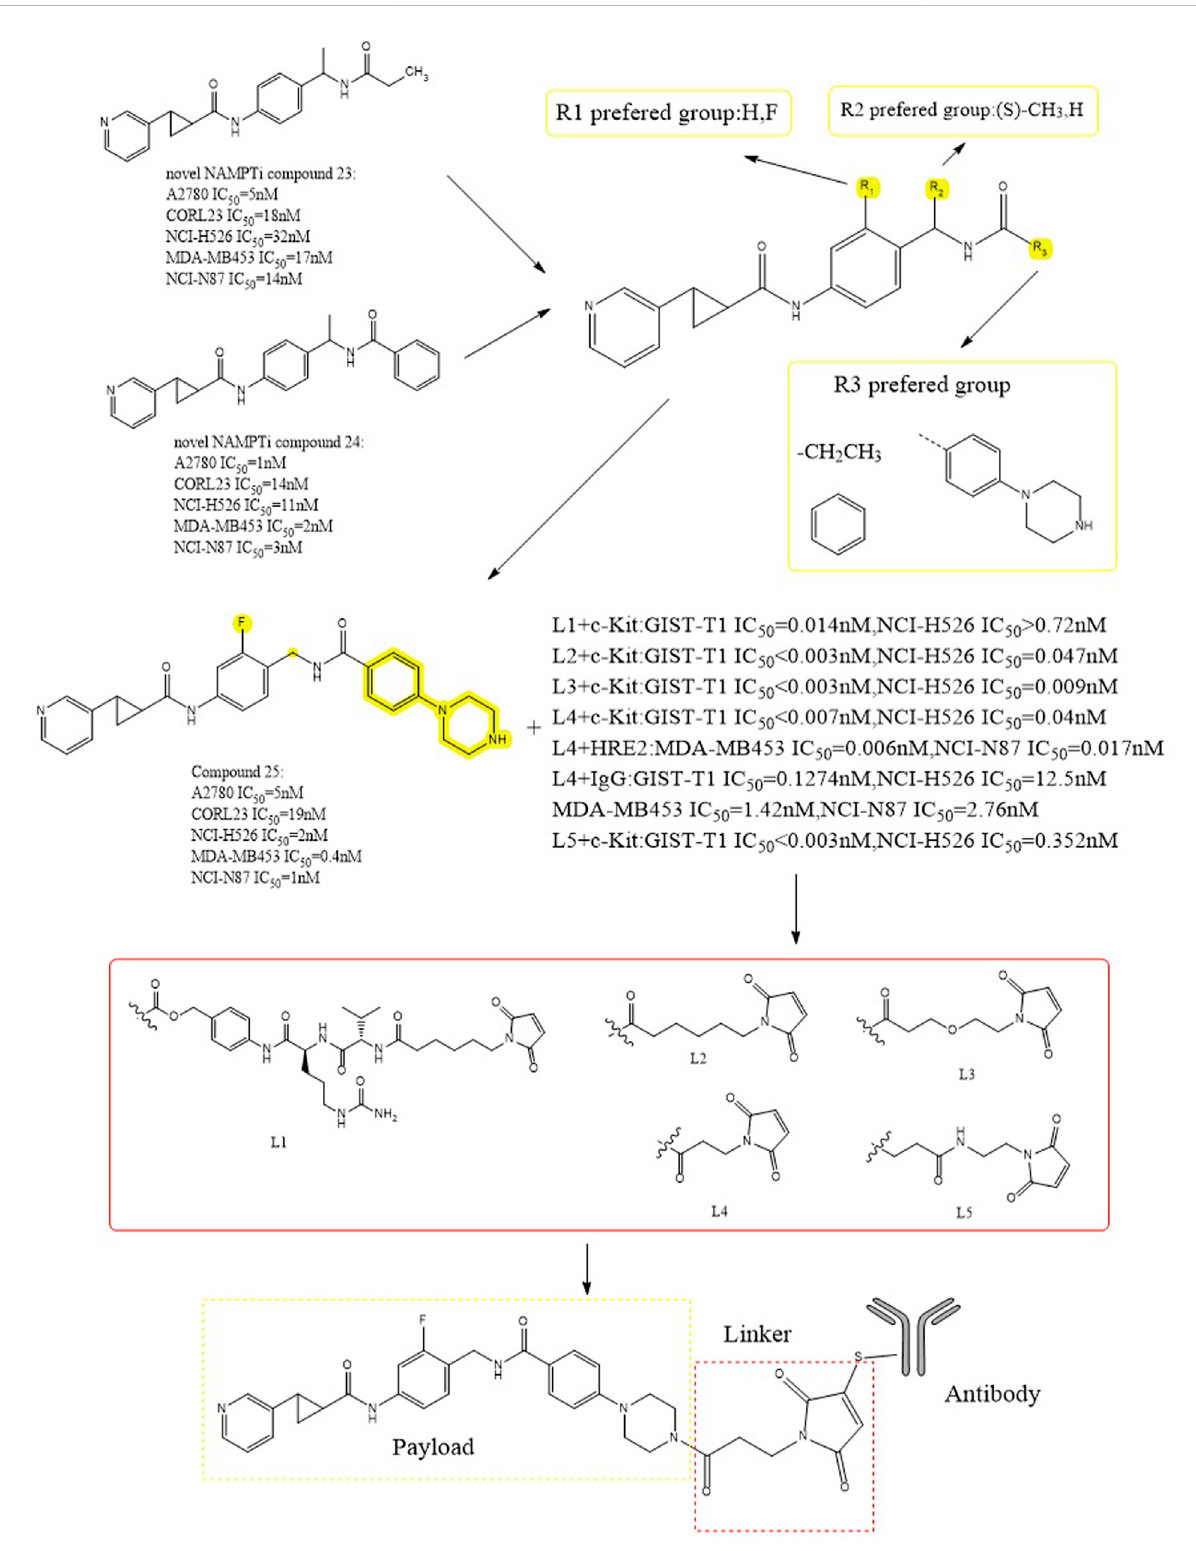
FIGURE 13 Structural design of